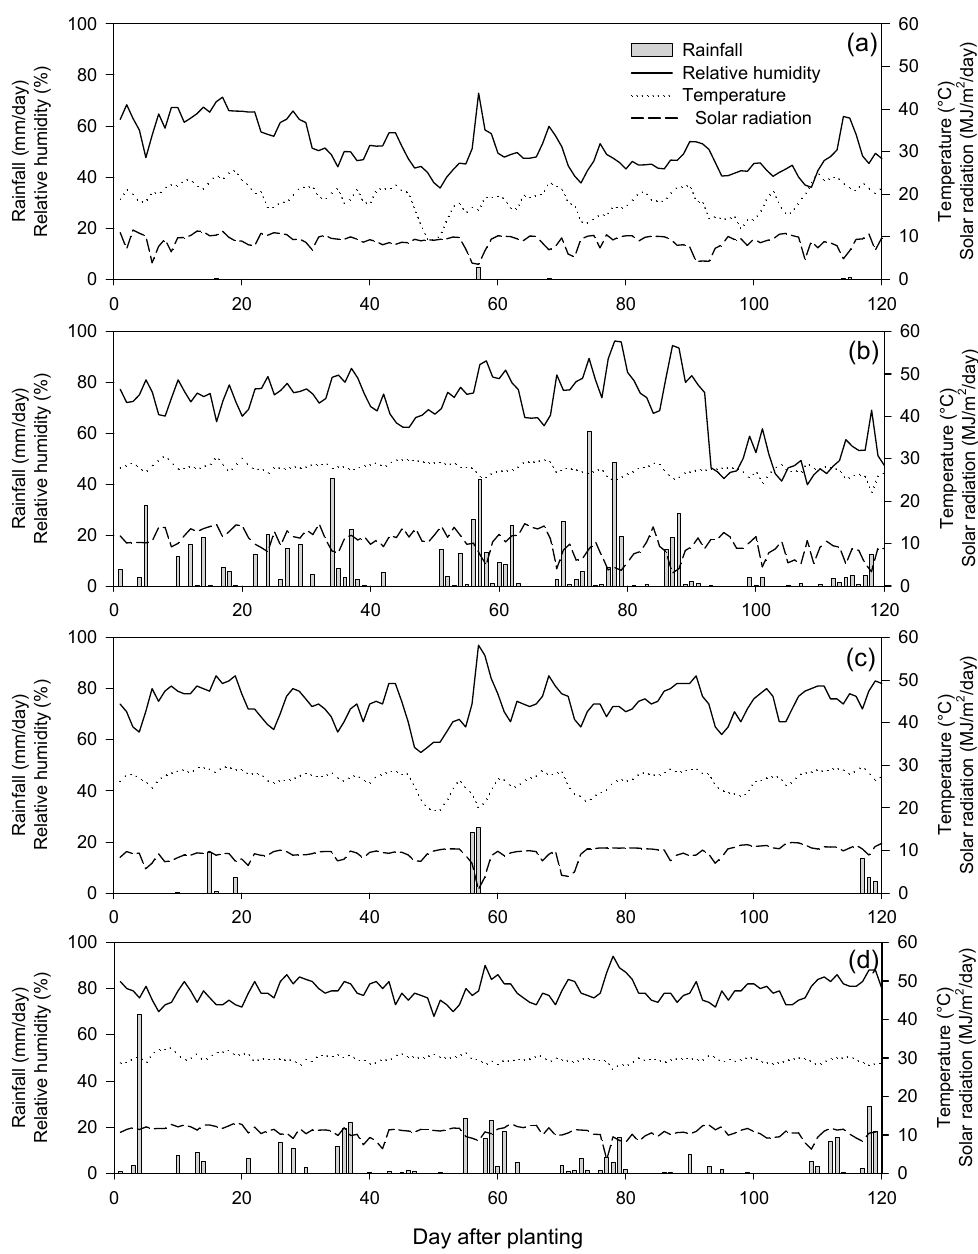
Figure A1. Rainfall, relative humidity, temperature and solar radiation during the crops growth at four environments. ( a ) Khon Kaen in the dry season 2017/2018, ( b ) Khon Kaen in the rainy season 2018, ( c ) Uthai Thani in the dry season 2017/2018 and ( d ) Uthai Thani in the rainy season 2018.